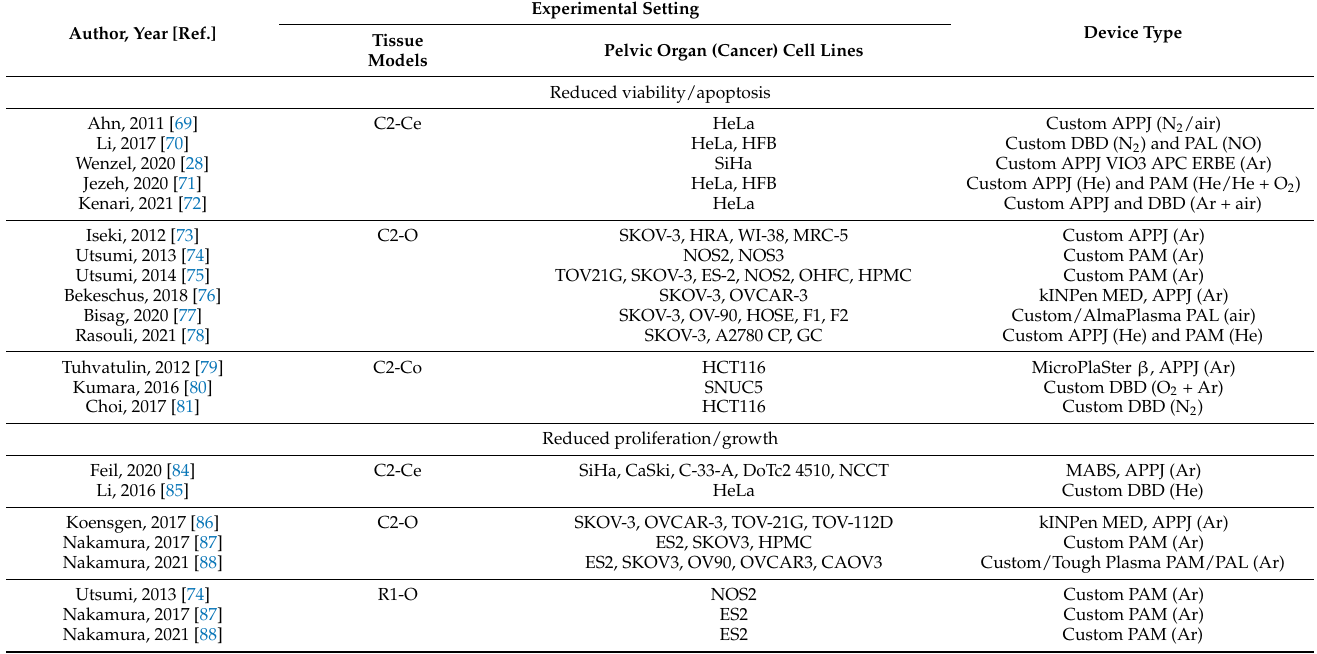
Table 3. Overview of CAP devices and experimental models, annotated as: C = cancer cell